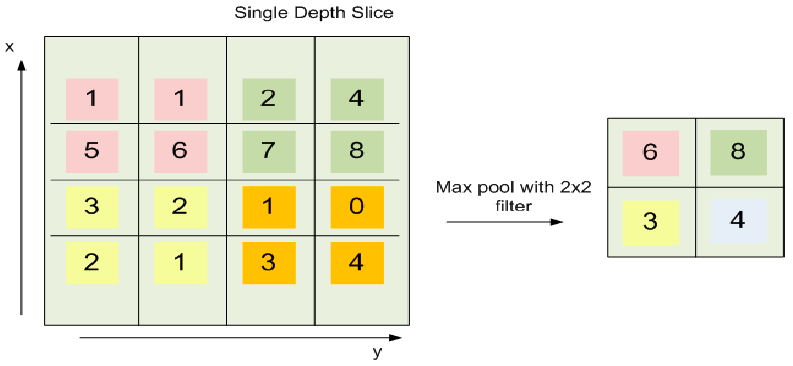
Figure 3. Maximum pooling layer.